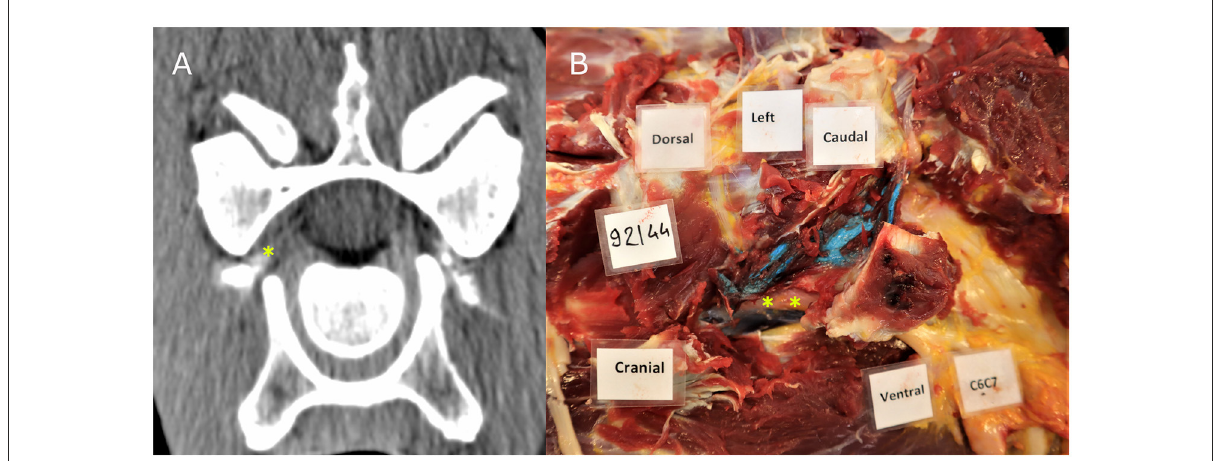
FIGURE2 CT image (A) showing contrast material in the intervertebral foramen where the cervical nerve root C7 is located; Dissection image (B) showing direct contact between blue latex with the cervical nerve root at the level of C6–C7. The nerve root and ventral branch of C7 are indicated by a yellow asterisk.